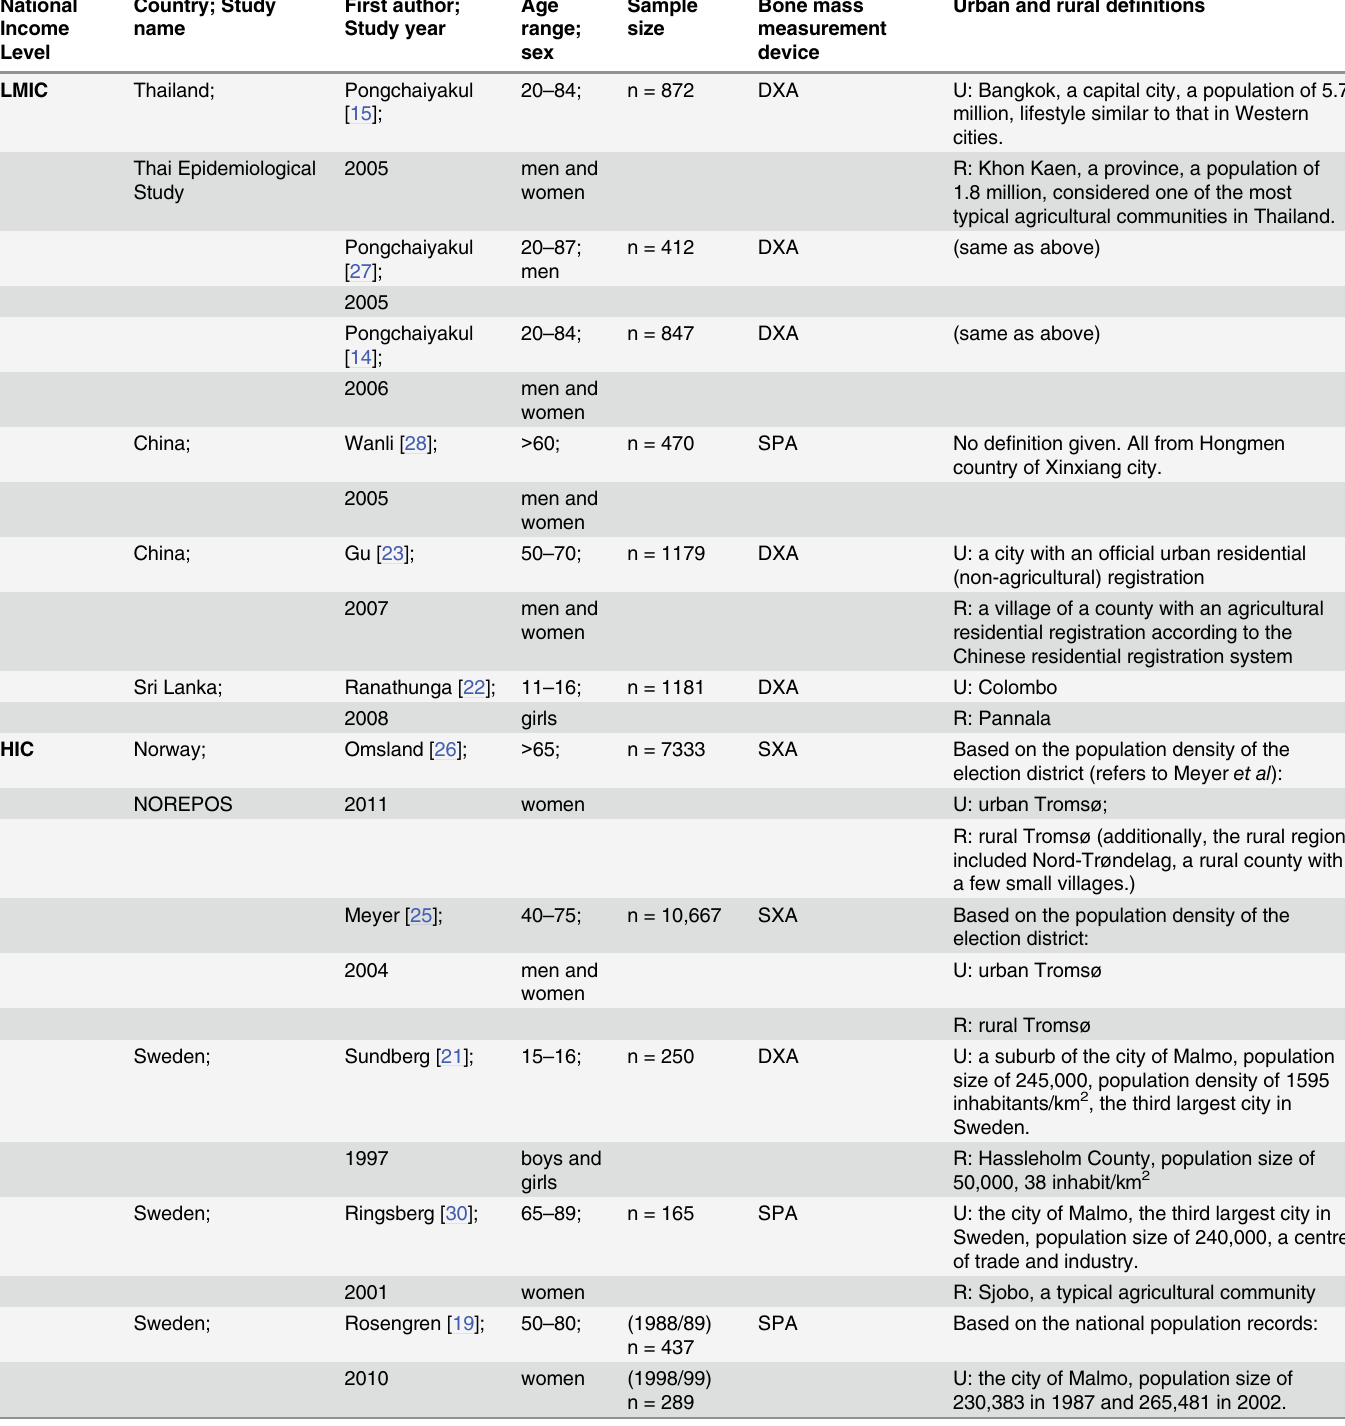
Table 1. Study characteristics of the included